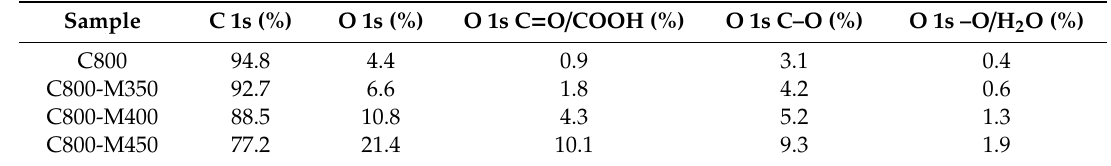
Table 2. Carbon and oxygen content determined by XPS data and results of the curve-fitting of the high-resolution XPS spectra for the O 1s